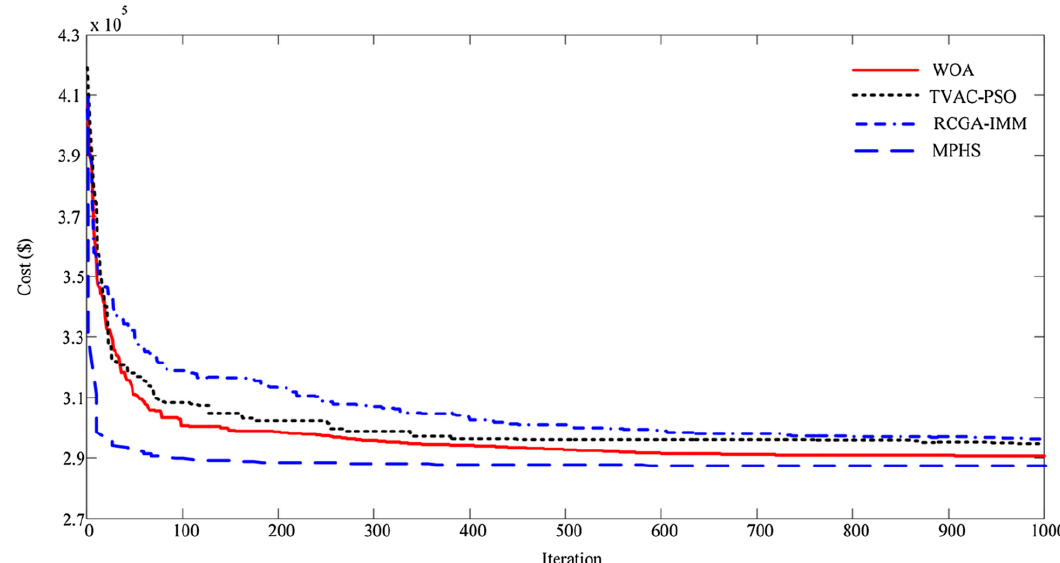
Figure 5. Comparison of the convergence characteristics of the MPHS algorithm and the other applied optimization algorithms to solve a CHPED case [99].